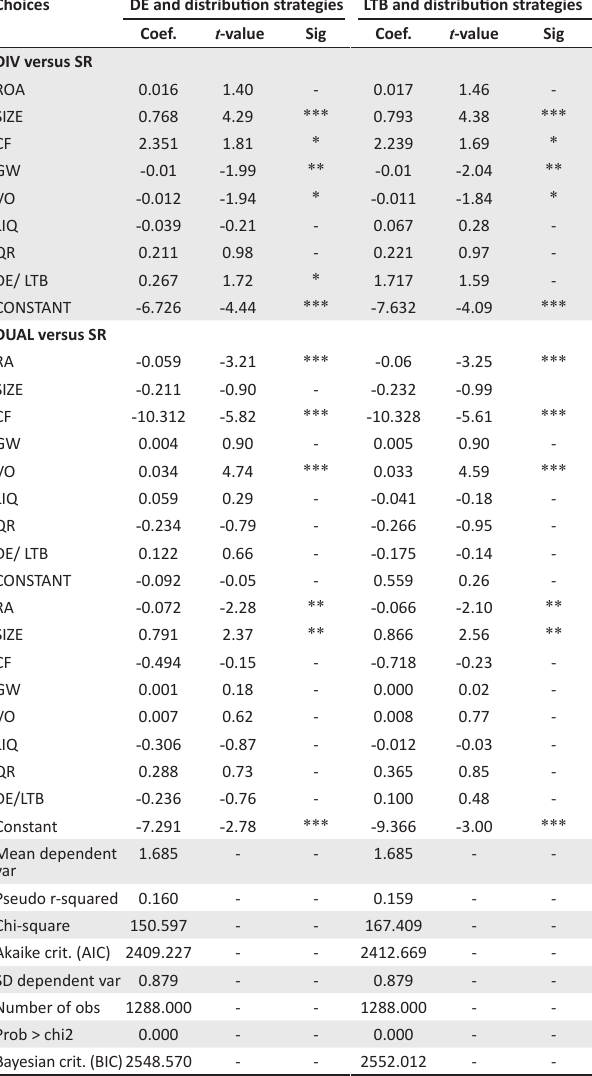
TABLE 6 : Fixed effects multinomial logistic regression estimation. Choices DE and distribution strategies LTB and distribution